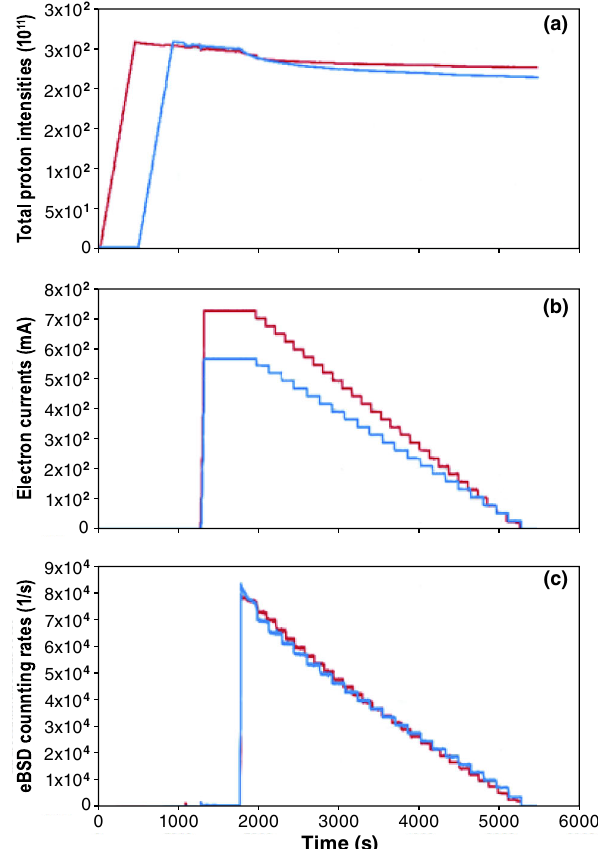
FIG. 16. The total proton intensities (a), RHIC electron lens electron current intensities (b), and corresponding eBSD counting rates (c) are shown as a function of time. The electron beam intensities are reduced in steps to optimize the benefits of the RHIC electron lenses [11]. The two colors indicate the results from each of the two RHIC